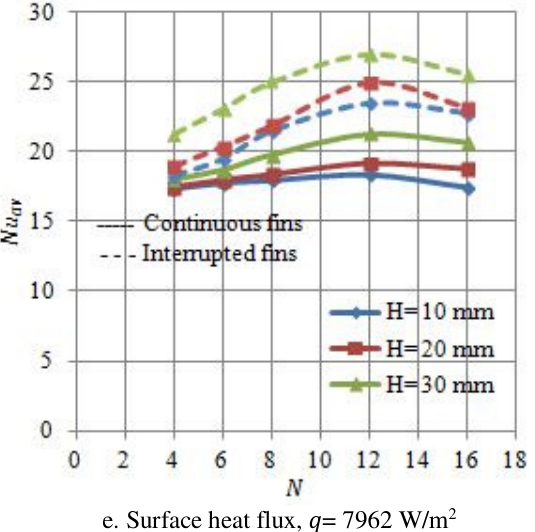
Fig. 8. Behavior of verage Nusselt number against fins number for different fin heights and surface heat